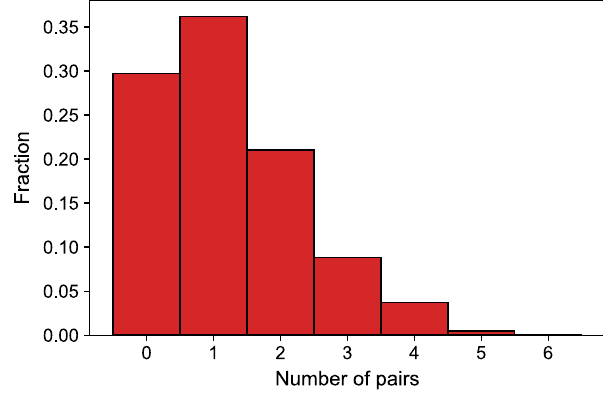
FIG. 10. Expected number of nearest-neighbor pairs per NV.